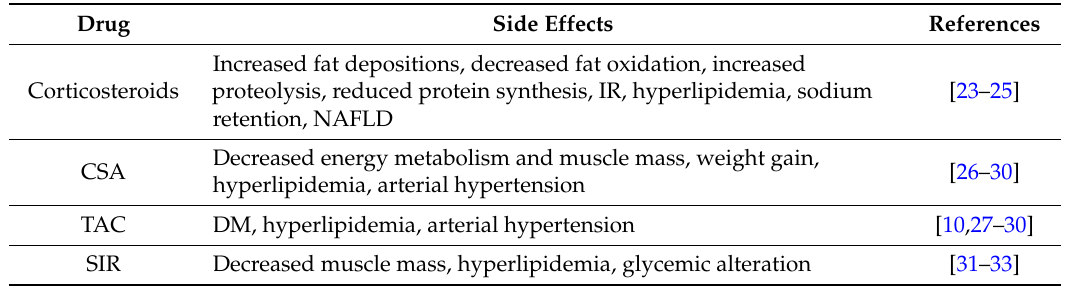
Table 2. Most used immunosuppressant drugs and main metabolic side effects. Drug Side